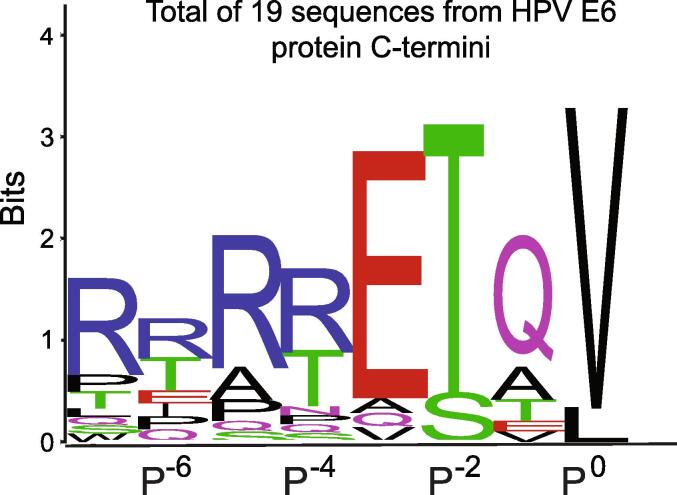
WebLogo analysis of PDZ motif-satisfying HPV E6 sequences. A WebLogo analysis of the C-terminal sequences of 19 E6 oncoproteins from various HPV strains reveals that the most common PDZ-targeting sequence motif in these proteins is RRRRETQV.